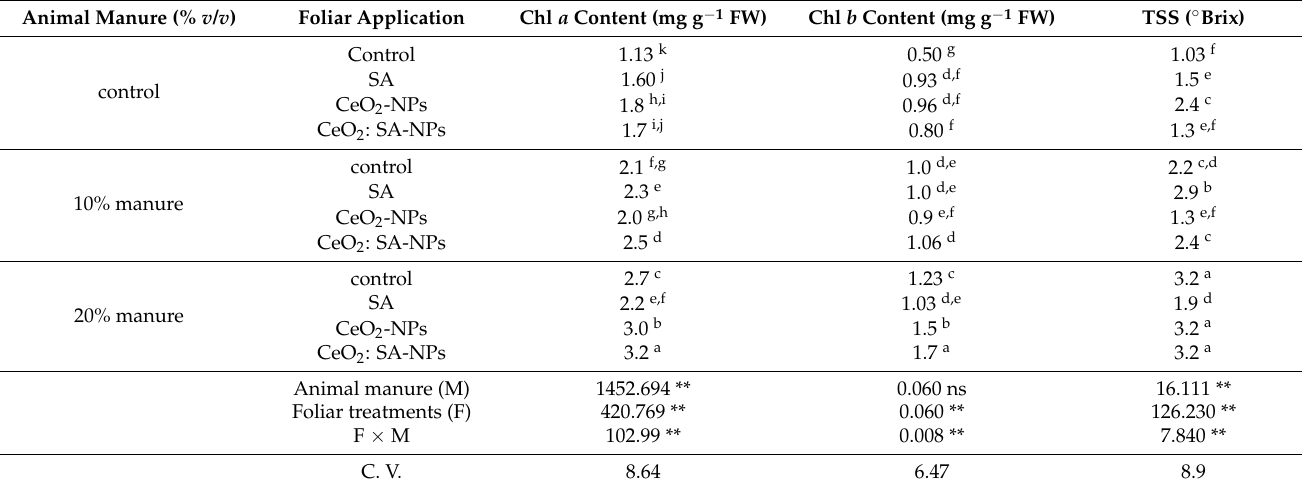
Table 5. Interaction effects of soil-based animal manure (0%, 10%, and 20% v / v ) use and foliar applications (no-foliar, SA, CeO 2 -nanoparticles, and CeO 2 : SA-nanoparticles) on Aloe vera L. plants’ chlorophyll a and b as well as total soluble solids (TSS)